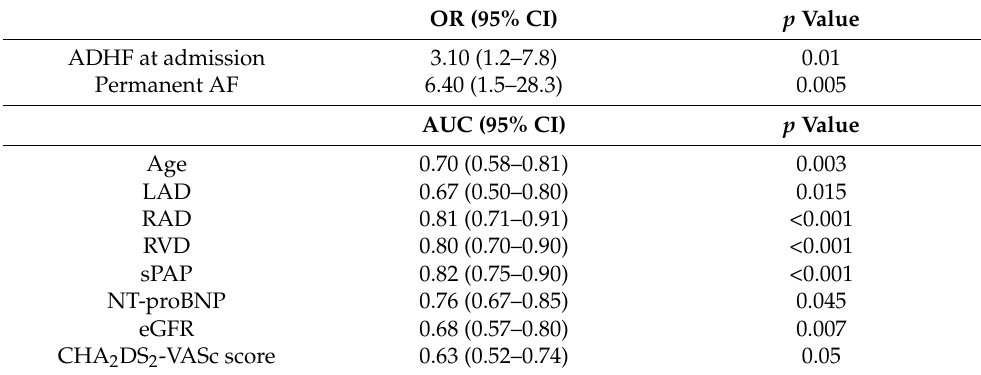
Table 3. Predictors of severe AF-TR—univariate